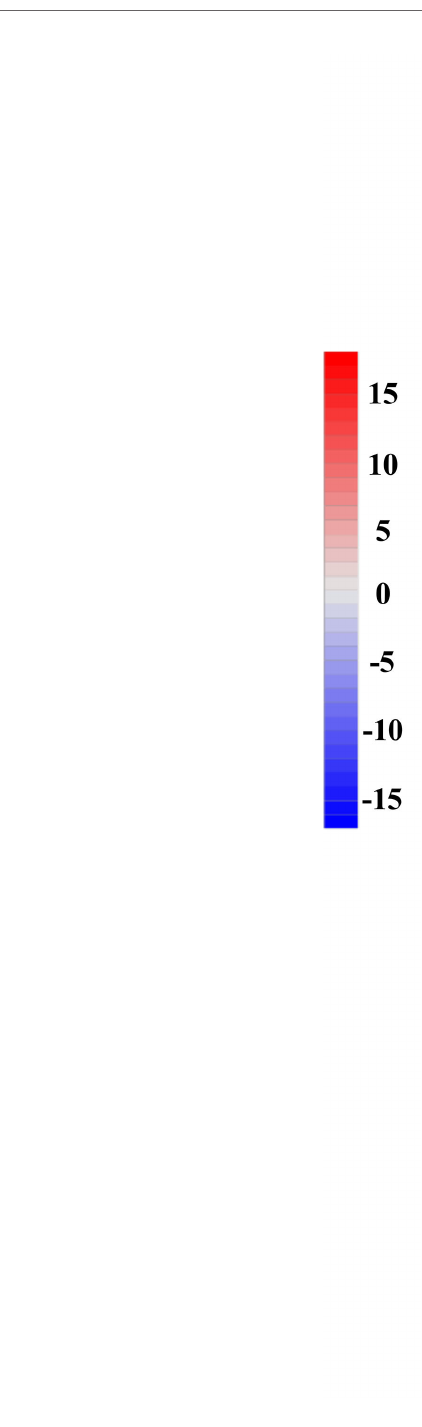
FIGURE 9 | Signi fi cant associations between microbial clades with sample metadata of interest. Heatmap summarizing all the signi fi cant associations between microbial clades and sample metadata of interest. Color key: -log (q-value) * sign (coef fi cient). Cells denoting signi fi cant associations are colored (red or blue) and overlaid with a plus (+) or minus ( − ) sign indicating the direction of association. Note that the expression of immune genes increase as the PC1 value of PCA increases, while plasma nutrient values showed the opposite trend ( Supplementary Table 3 ). For immune functions, except the Synechococcus.CC9902 , the gut immune gene expressions were found to be positively correlated with the relative abundance of other 11 taxa. Regarding plasma nutrient levels, the plasma nutrient levels were found to be negatively correlated with the relative abundance of Clostridium sensu stricto 8 . For DI supranuclear vacuolization, the higher relative abundance of the microbial clade was signi fi cantly correlated with abnormal features of distal intestinal supranuclear vacuolization. The signi fi cant association was set at FDR ( q-value ) < 0.25. f__, family; o__,